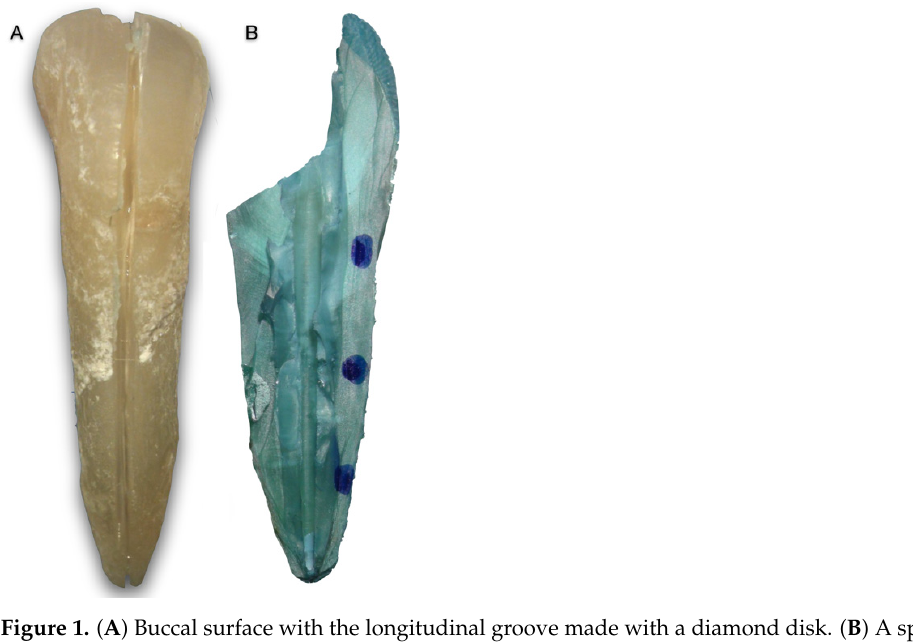
Figure 1. ( A ) Buccal surface with the longitudinal groove made with a diamond disk. ( B ) A split half of a sample ready for SEM